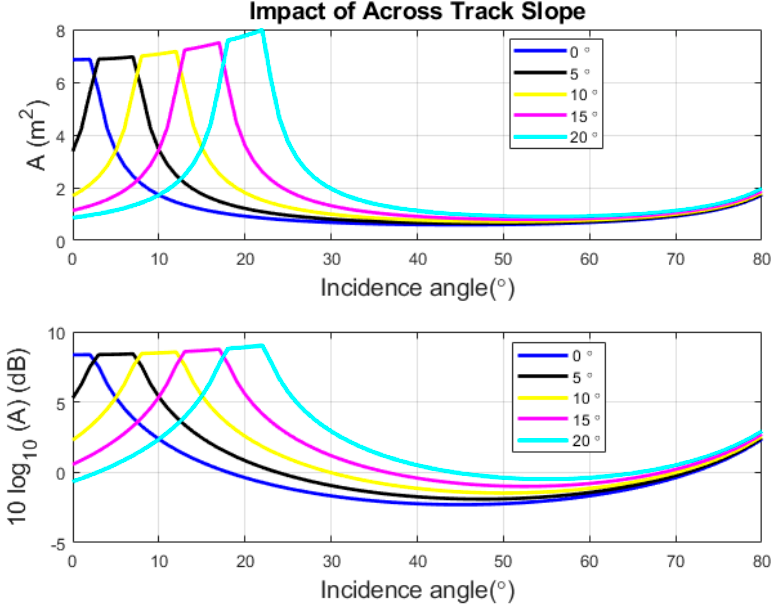
Figure 6. Insonified area corrections ( A ) in m 2 and dB re. 1 m 2 for various across-track slope values for a depth of 100 m, pulse length of 150 μs , and along-track/across-track beamwidths of 1.5°.